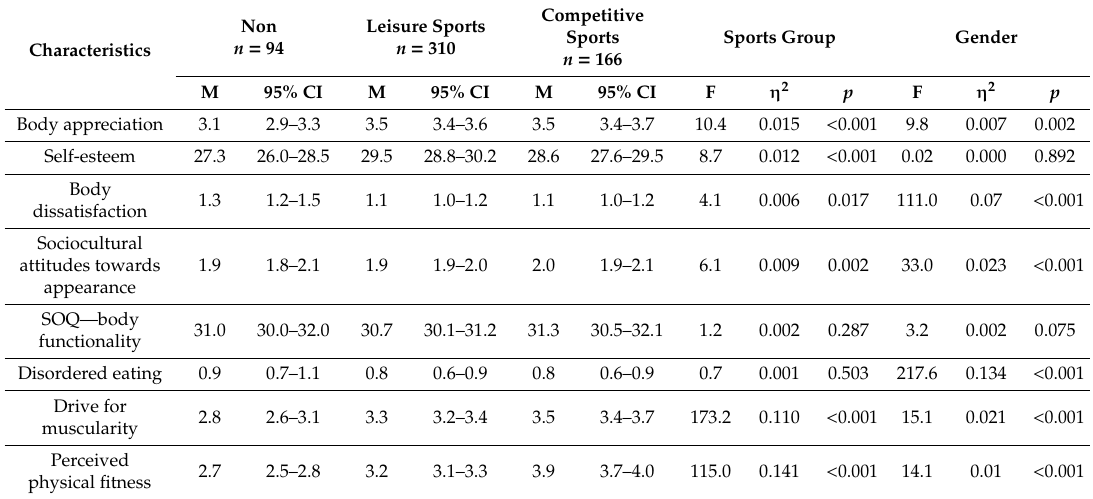
Table 2. The comparison of body image, disordered eating behaviours and lifestyle-related factors in sports groups in a sample of boys ( n = 570).